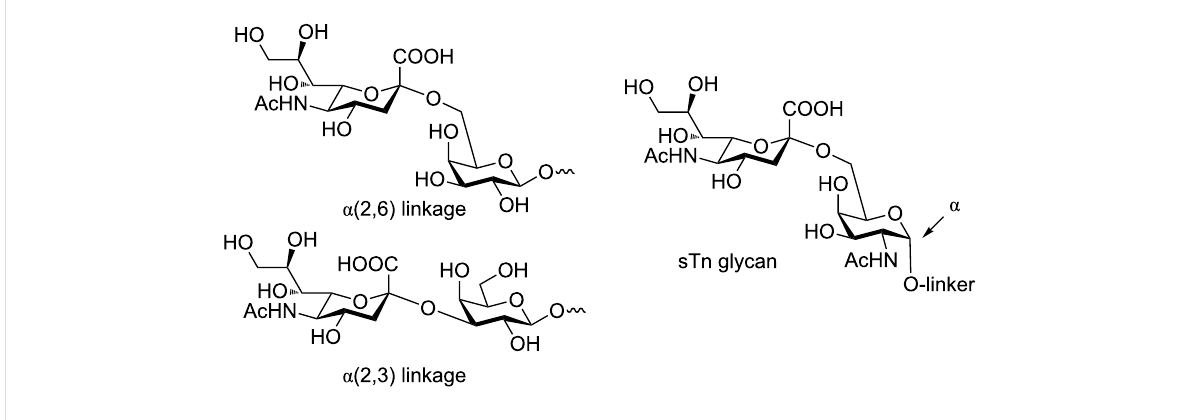
Figure 1: Terminal sialic acids are typically α -(2,3) or α -(2,6) linked to galactose (Gal) such as in the tumour-associated antigen sialyl Tn (sTn).